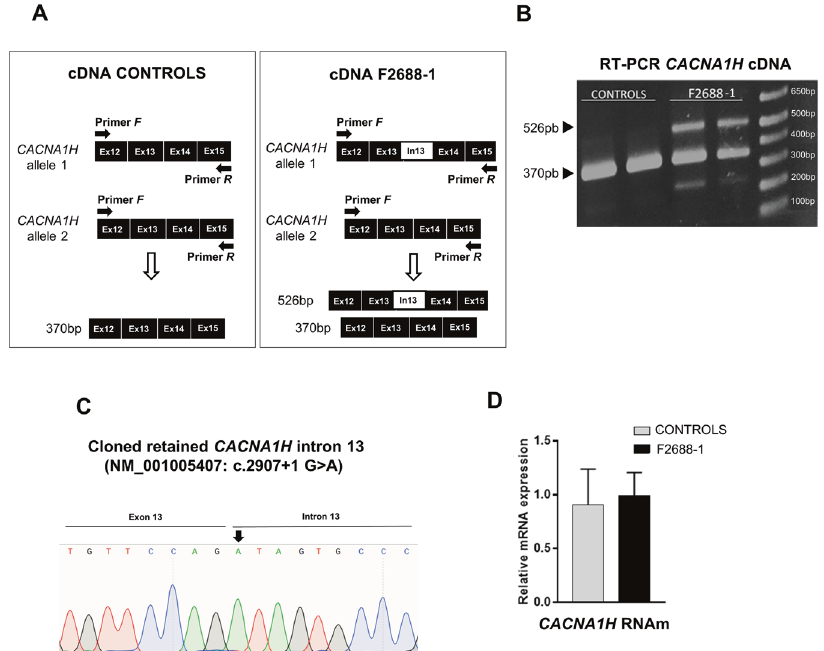
Fig. 1 Splice donor site variant in intron 13 of the CACNA1H gene in patient F2688-1 results in retention of the entire intron in the mature mRNA. A Schematic representation of intron 13 (In13) retention in the CACNA1H transcript showing the locations of primers for conventional RT-PCR. The PCR band corresponding to the wild-type allele is 370 bp long, whereas the band corresponding to the mutant allele is 526 pb long due to retention of intron 13 in the mature transcript. B Representative image of agarose gel electrophoresis showing conventional RT-PCR products. The 526 bp PCR product of the mutant allele is only observed in F2688-1-derived NPCs ( n = 2 iPSC clones- derived NPCs). C Sanger sequencing of the cloned 526 bp PCR band con fi rmed intron 13 retention in the mature CACNA1H transcript. The location of the variant NM_001005407:c.2907 + 1 G>A is shown. D Quantitative RT-PCR demonstrated that the relative transcription levels of CACNA1H are not changed in F2688-1-derived NPCs ( n = 2 iPSC clones-derived NPCs) compared with control NPCs (Controls, n = 4). The bar graph shows the median value and interquartile range for each